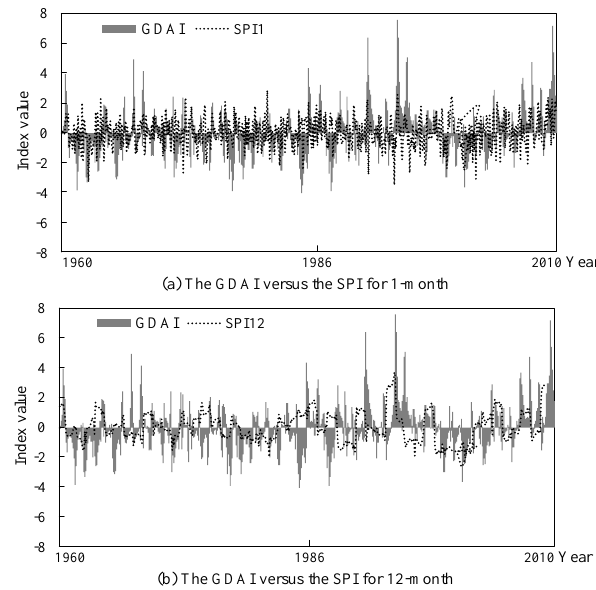
Figure 9. Compared the GDAI with the SPI in Gongzhuling city from 1960 to 2010.